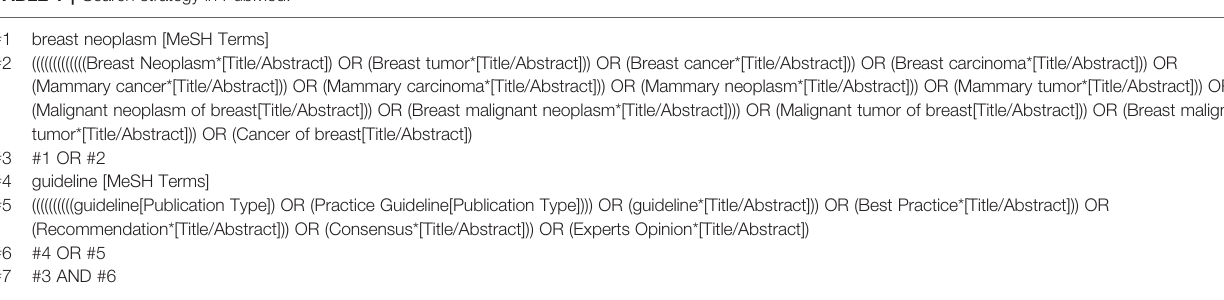
TABLE 1 | Search strategy in